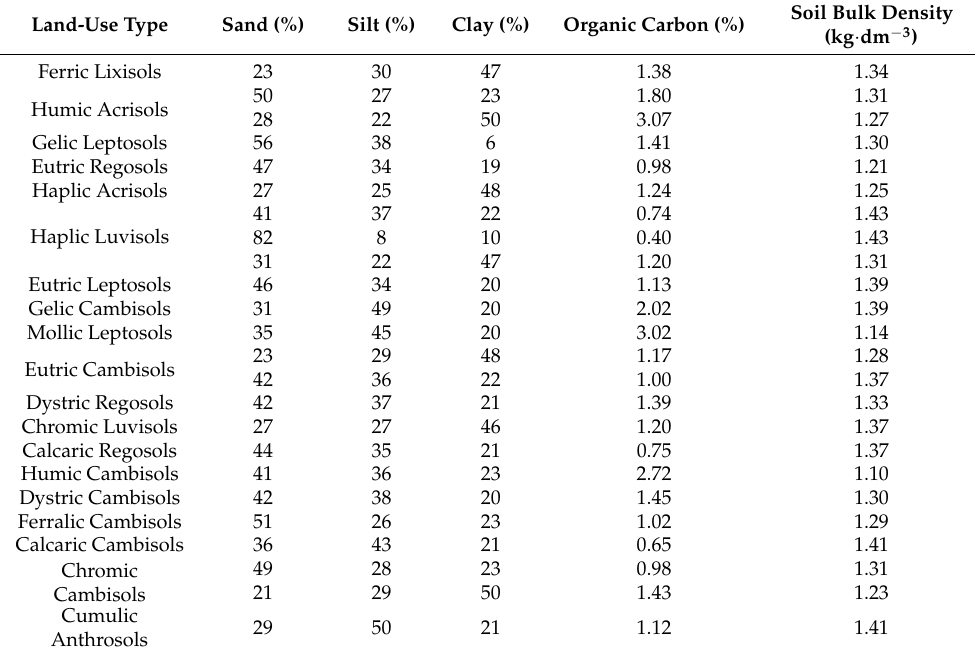
Table 2. Soil texture, organic carbon and soil bulk